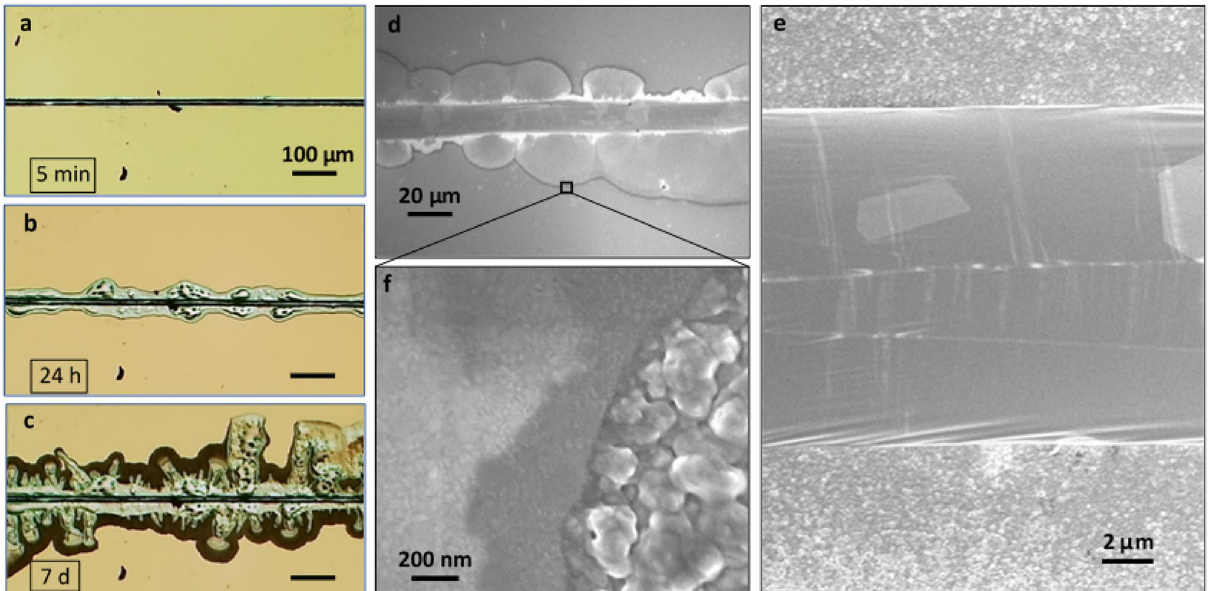
Figure 6. Surface spreading and reactivity. ( a – c ) Optical microscopy images of a segment of the patterned line in Fig. 5. The sample was kept inside a clean container at room temperature for several weeks. Image ( a ) was taken immediately after patterning showing a clear line, while ( b ) and ( c ) were taken 24 h and 7 days after patterning, respectively. The gradual spreading of the fronts is clearly visible as Ga and In form alloys with Au. ( d – f ) are electron micrographs of the pattern in ( b ). Large crystals are observed inside the line itself ( e ). Higher magnification of the front in ( f ) reveals different crystallite formation, varying in size as a function of the distance from the main source, from larger Ga-rich to smaller ones until the polycrystalline gold coating is